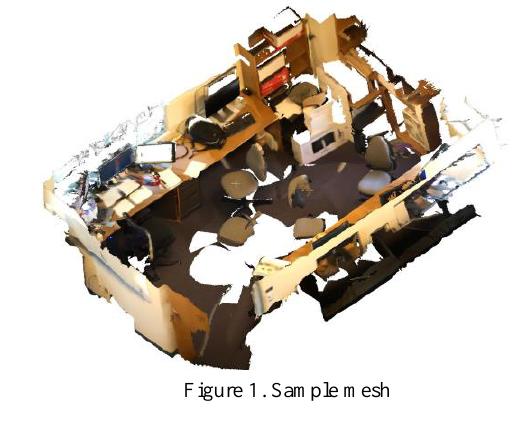
Figure 1. Sample mesh